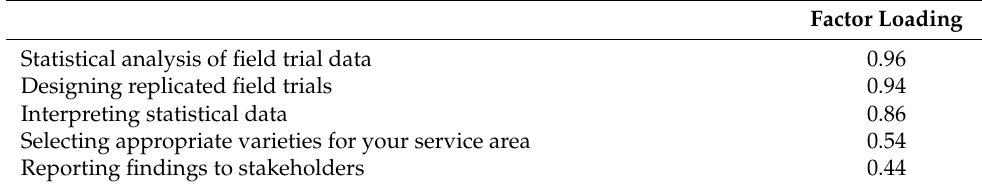
Table 20. Factor loading and items of importance in applied research after factor rotation.